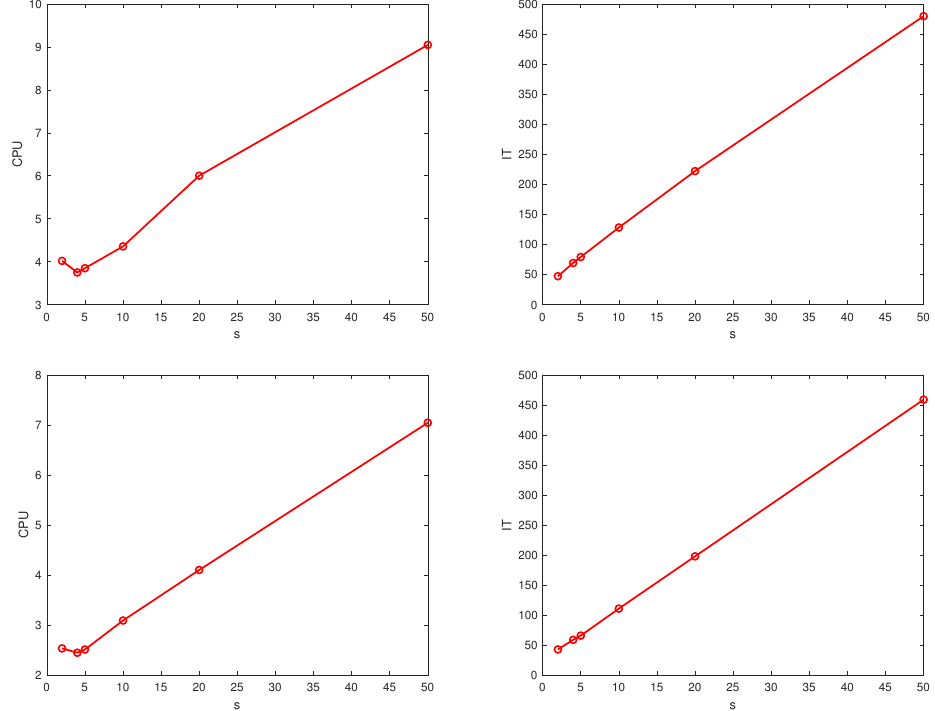
Figure 3. CPU and IT of the TRAK and TRAK F algorithms with extrapolated stepsize and different number of partitions. Upper : TRAK. Lower : TRAK F